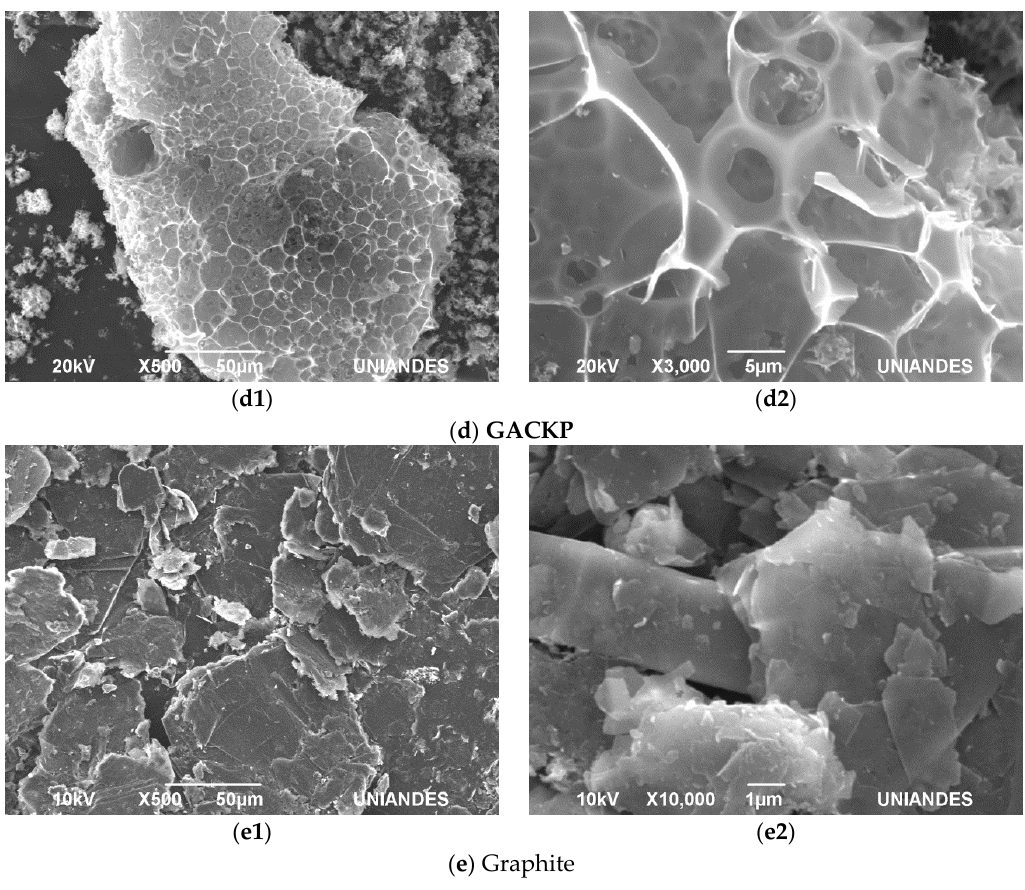
Figure 6. Scanning electron microscopy (SEM) micrographs of solids ( a ) MOF-199; ( b ) MCM-41; ( c ) SBA-15; ( d ) GACKP; ( e ) Graphite.